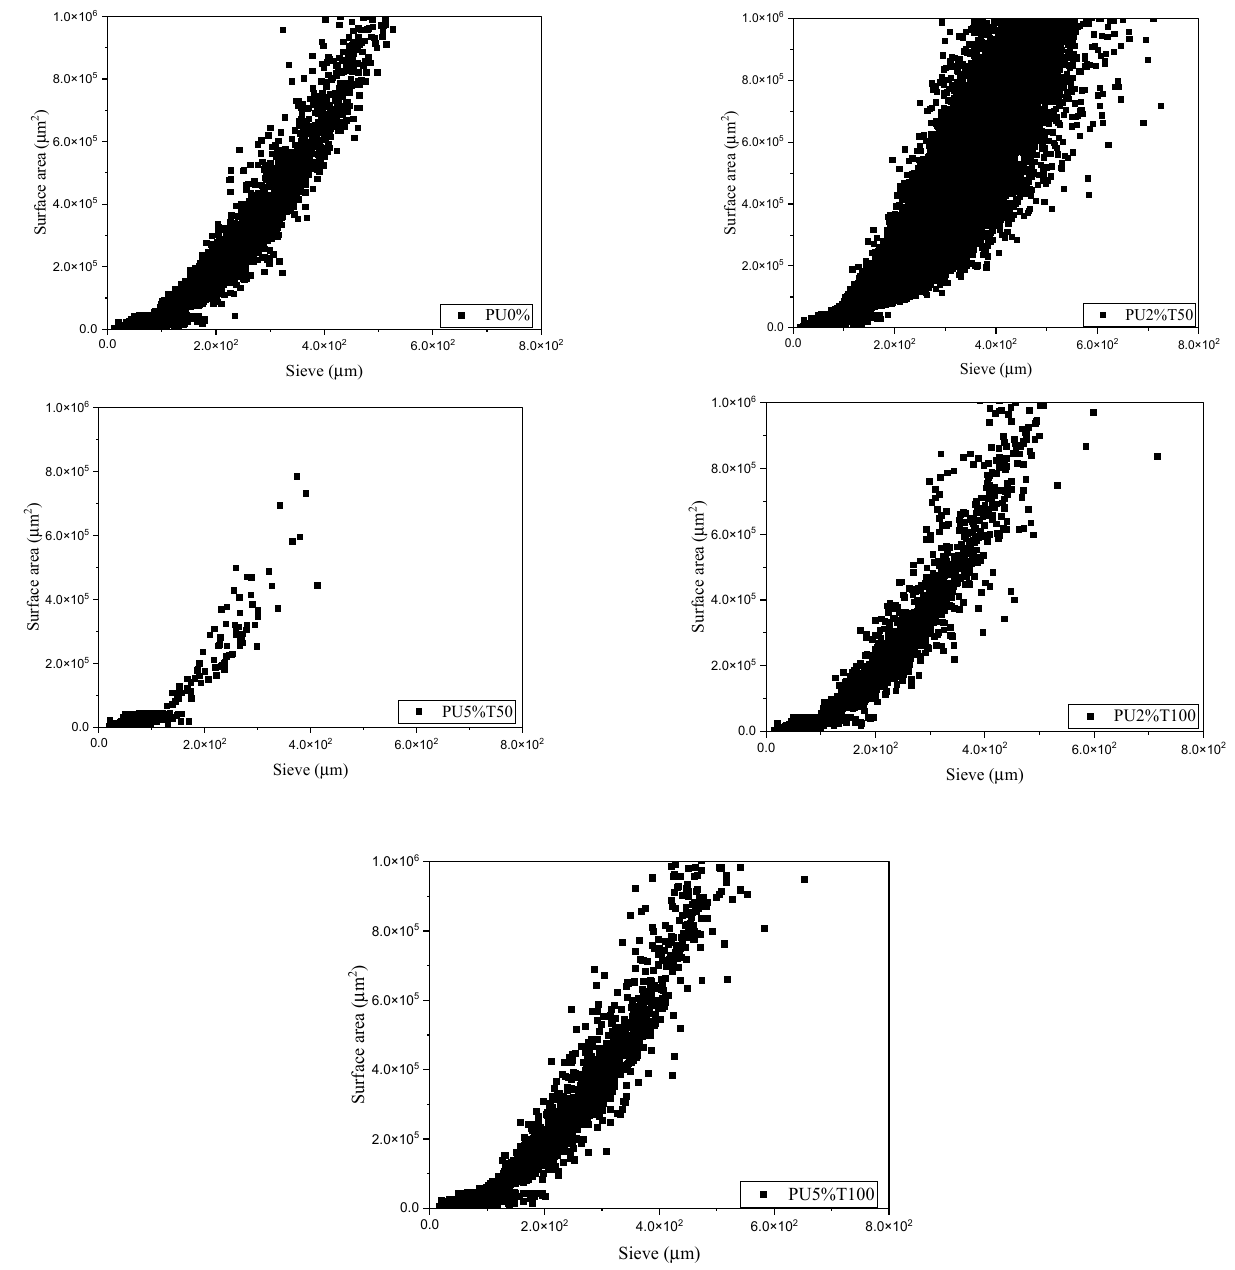
Figure 5. Dispersion analysis: size vs. surface area of polyurea mortars.